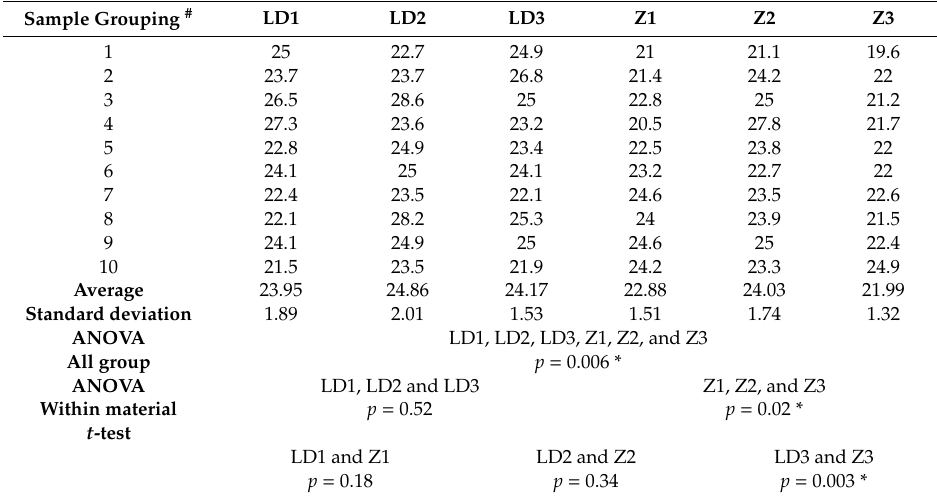
Table 2. Maximal temperatures ( ◦ C) during Er:YAG laser